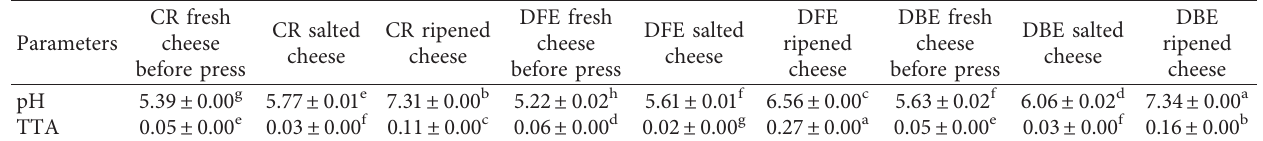
Table 8: pH and TTA of Danbo cheese (before press, salted, and